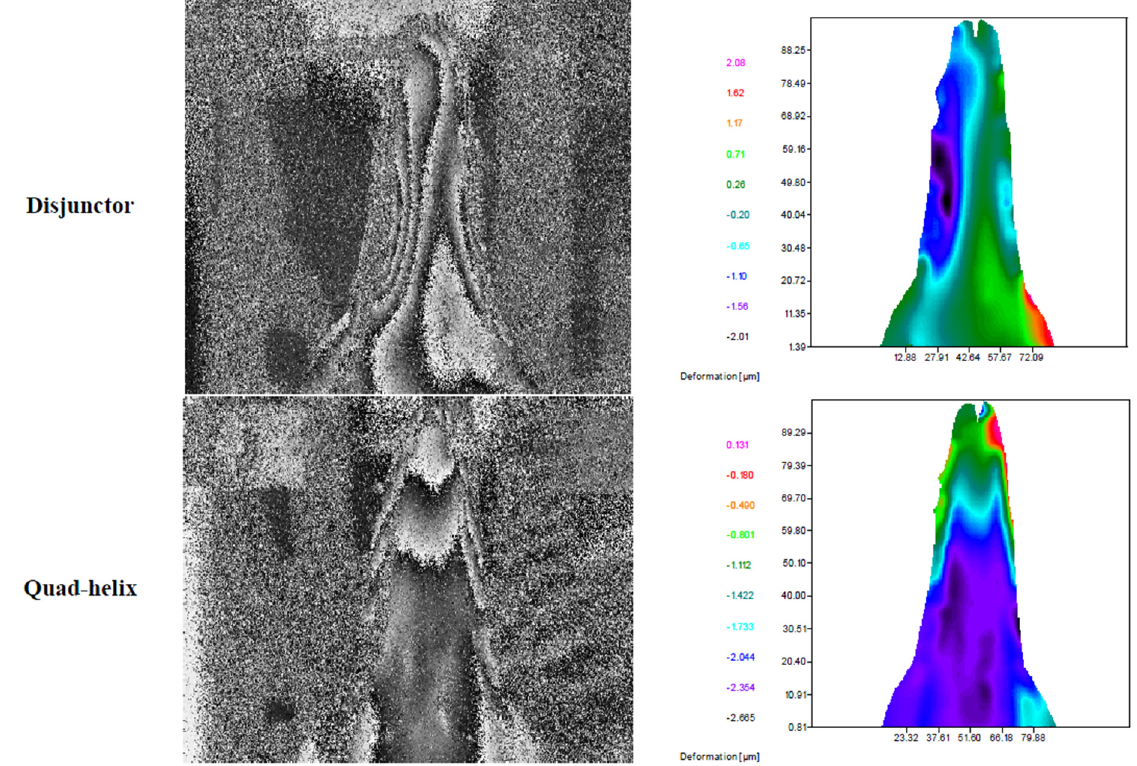
Figure 3. Displacement field induced by two orthodontic devices: Disjunctor and Quad-helix. Left: phase map; Right: displacement field calculated